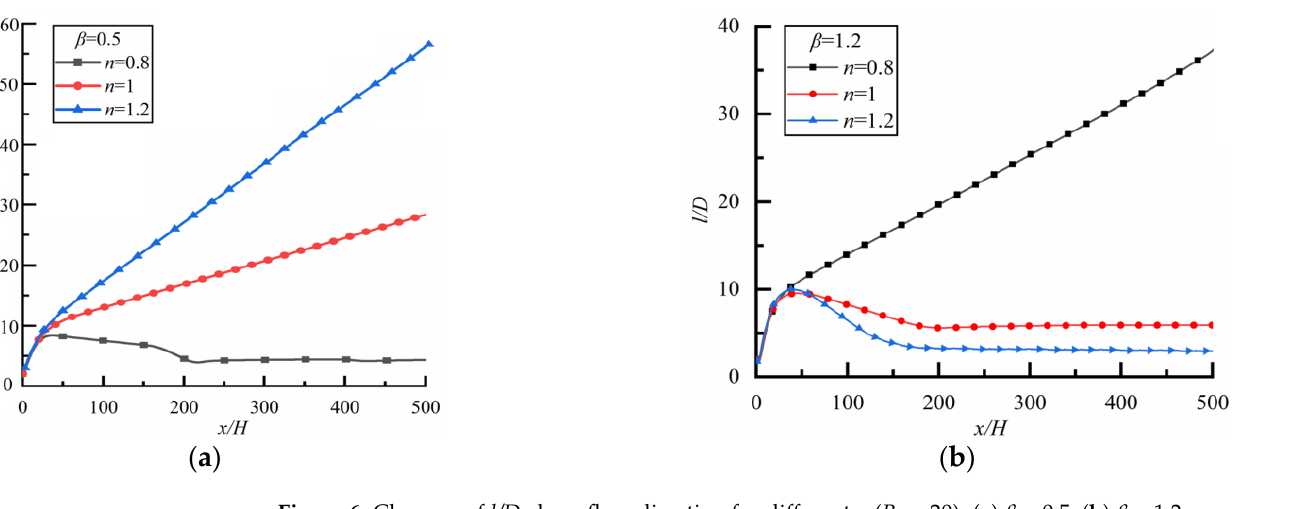
9 of 16 Figure 5. Changes of l/D along flow direction for different n ( Re =20). 4.1.2. Two Particles with Different Sizes Two particles with different sizes are located initially on the same horizontal line with spacing l =2 D . Figure 6 shows the changes of l/D along the flow direction for differ-